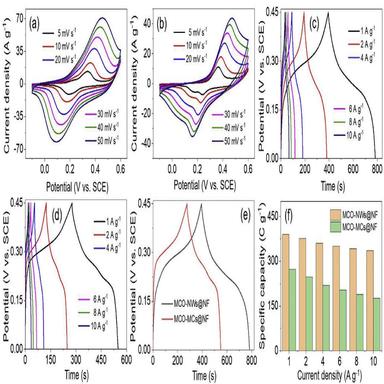
Electrochemical performance of NF-supported MgCo2O4 measured in three-electrode system: the CV curves of (a) MCO-NWs@NF and (b) MCO-MCs@NF electrodes tested at scan rate ranging from 5 to 50 mV s¡1 , the GCD curves of (c) MCO-NWs@NF and (d) MCO-MCs@NF tested at current density ranging from 1 to 10 A g¡1 , (e) the GCD curves at 1 A g¡1 for MCO-NWs@NF and MCO-MCs@NF, and (f) the rate performance of MCO-NWs@NF and MCO-MCs@NF electrodes.